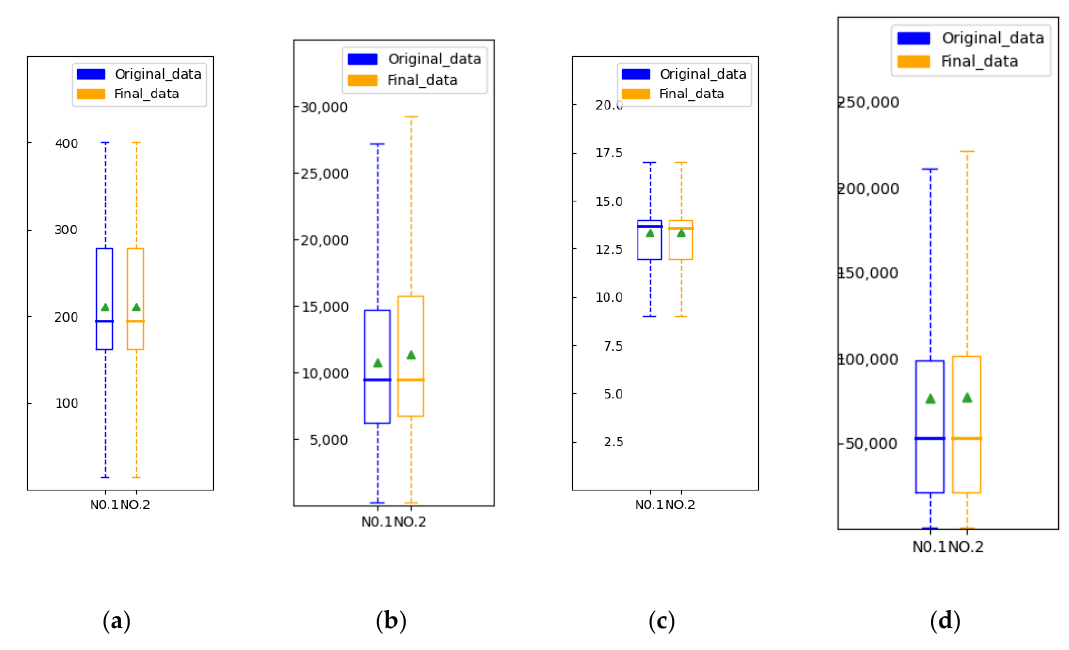
Figure 11. Boxplots of descriptive statistics for the original data (blue box) and final data (orange box): ( a ) L, ( b ) AEP, ( c ) V, and ( d ) NT. The green triangle represents the mean value.